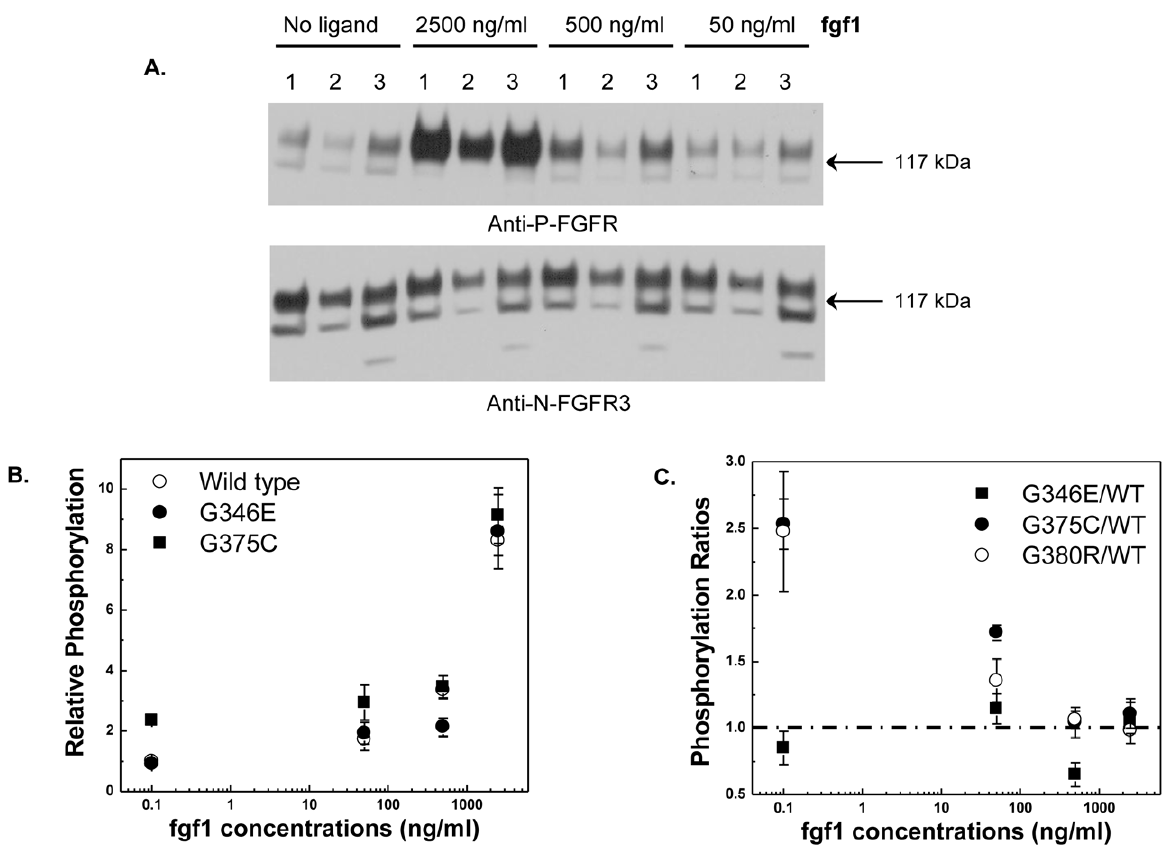
Figure 2. Effect of the achondroplasia mutations on FGFR3 phosphorylation. HEK 293 cells were transfected with plasmids encoding FGFR3/WT, FGFR3/G346E and FGFR3/G375C. Different concentrations of fgf1 , ranging from 50 to 2500 ng/ml, were added to the serum-free medium. After incubating for 10 min with ligand, cells were lysed and analyzed using Western blotting. A. A typical Western blot result. FGFR3 was detected with anti-N-FGFR3 (H-100) antibodies (bottom) or anti-P-FGFR antibodies (top). Lanes 1: FGFR3/WT, Lanes 2: FGFR3/G346E, Lanes 3: FGFR3/ G375C. B. The relative phosphorylation levels of the receptors were calculated by dividing the anti-P-FGFR staining intensities by the anti-N-FGFR3 staining intensities. The phosphorylation levels increase with ligand concentration. C. The phosphorylation levels of FGFR3/G375C, FGFR3/G346E and FGFR3/G380R were divided by that of FGFR3/WT. The G380R data are from [35].